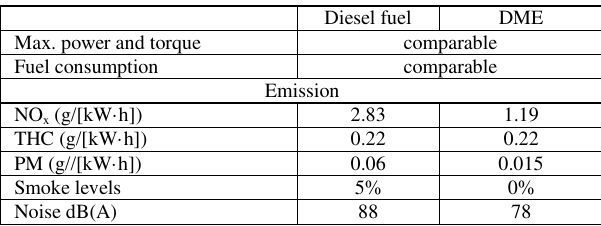
Table 2. Comparison of parameters of SI engine fuelled with diesel fuel and DME [24]